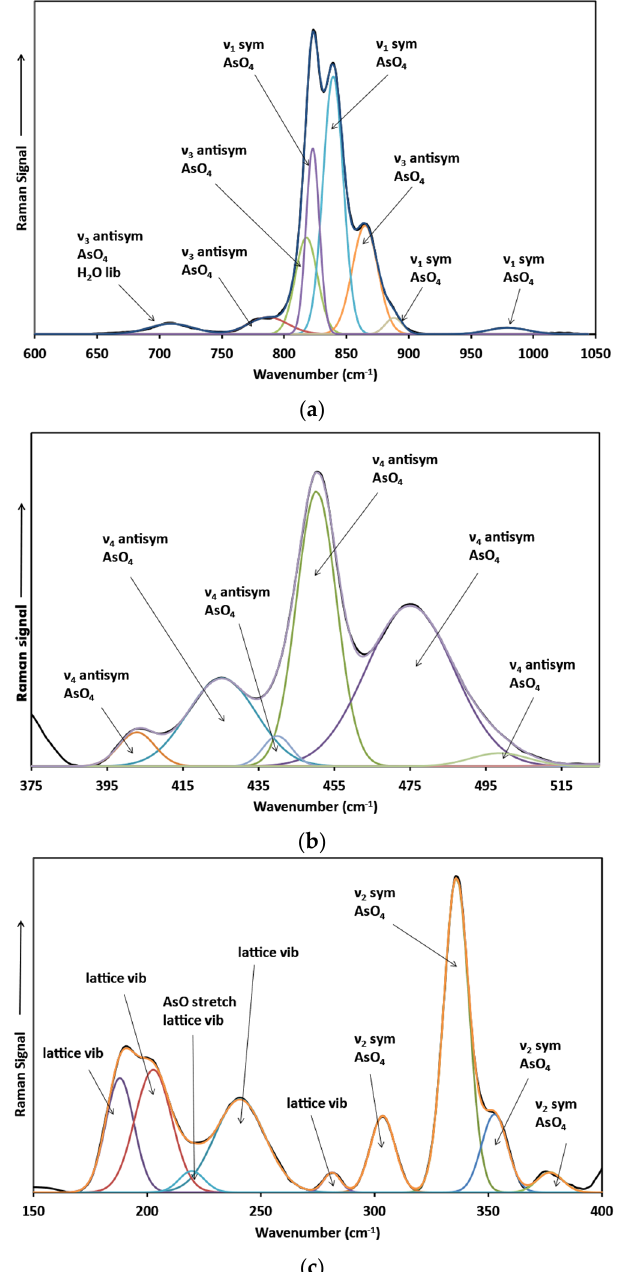
Figure 5. Raman spectra with band fitting of roselite ( a ) in the 600–1050 cm − 1 region, ( b ) in the 375–525 cm − 1 region, and ( c ) in the 150–400 cm − 1 region.